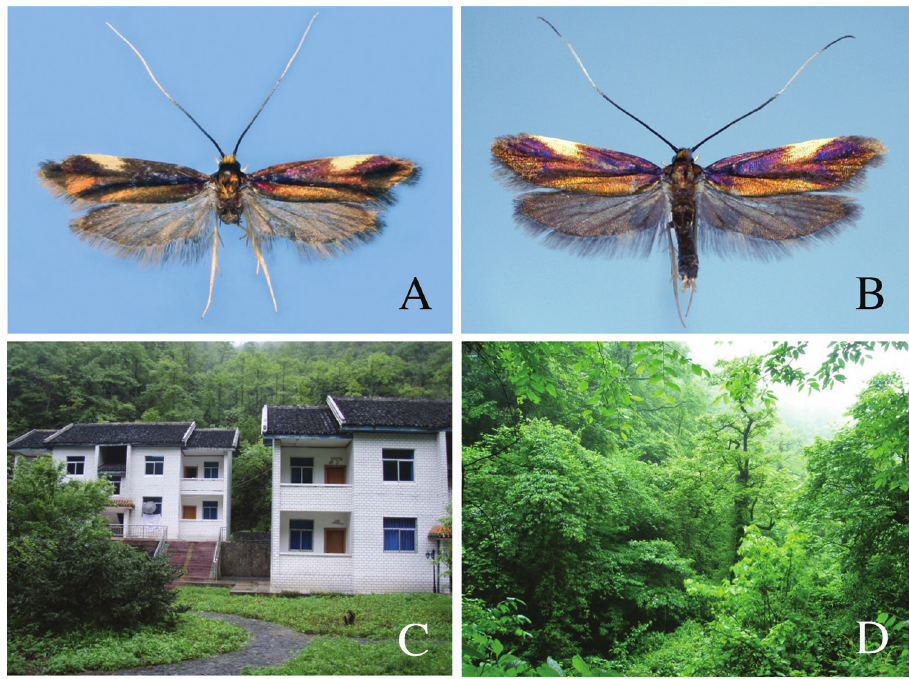
Figure 4. Adult and type locality of Roeslerstammia tianpingshana sp. n. A Holotype male B Paratype female C Type locality of R. tianpingshana sp. n., Tianpingshan, Hunan, China D Vegetation near the type